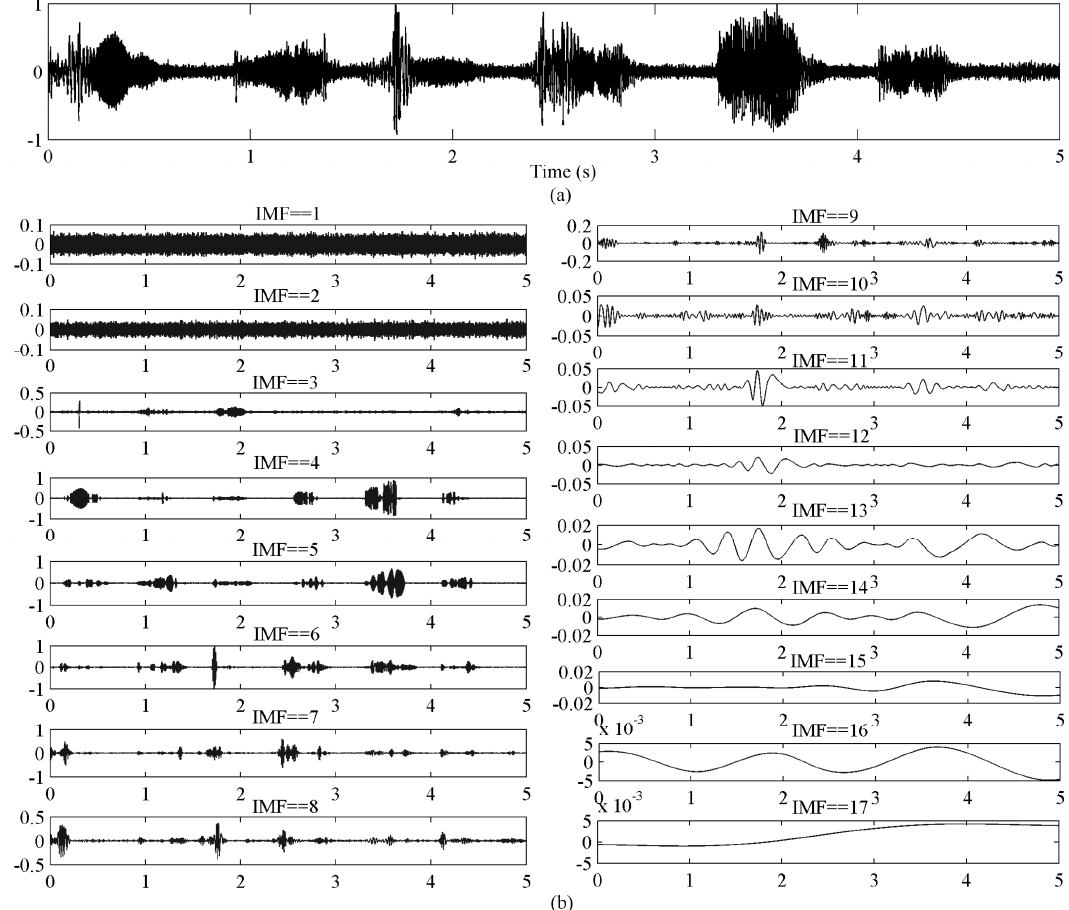
Figure 3. ( a ) The original radar speech signal contaminated by white noise; ( b ) the decomposition of the original radar speech corrupted by white noise using EMD.